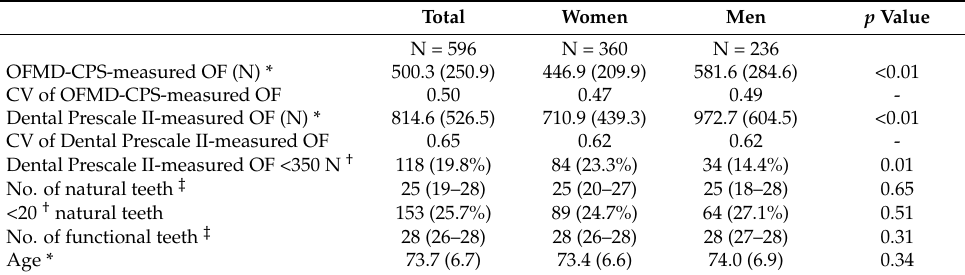
Table 1. Characteristics of the study population (n = 596).